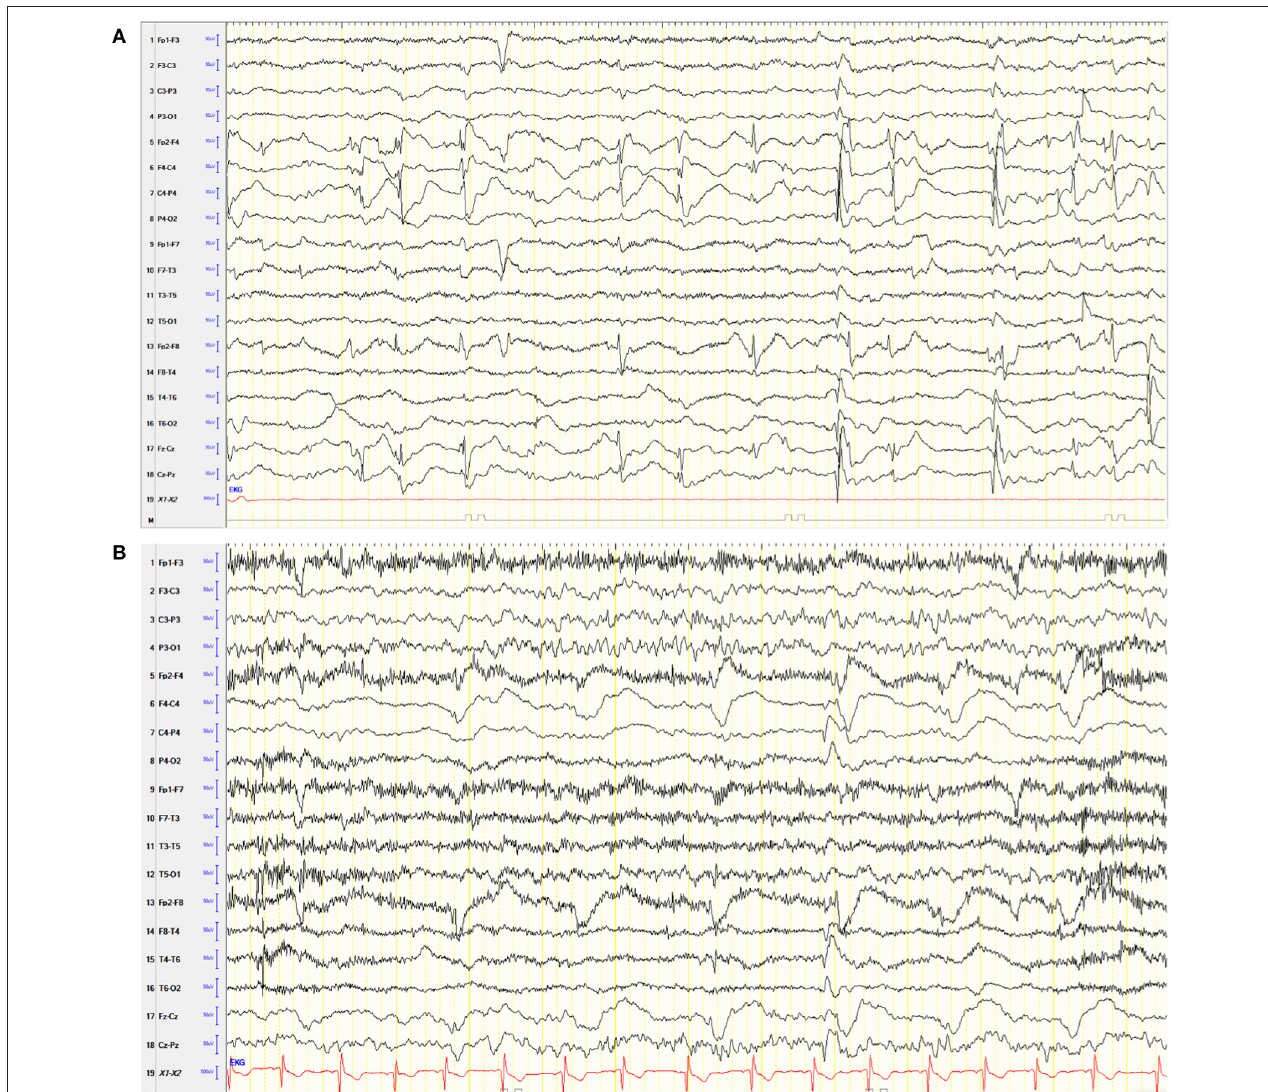
FIGURE 2 | Electroencephalogram (EEG) of the patient. (A) Awake EEG after hemispherotomy under VPA. Hypersynchronous activity on the right frontocentral side over the disconnected hemisphere without evidence of clinical seizure signs and without evidence of transition to the left. (B) Six months after surgery without VPA, the EEG showed continuous right hemispheric dysfunction, hypersynchronic right frontocentral activity, and activation during sleep without clinical